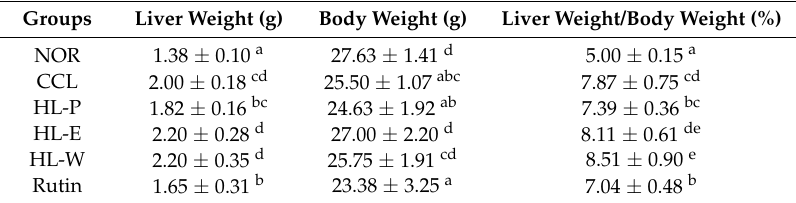
Table 2. The effects of red quinoa and its extracts on body weight, liver weight and liver weight/body weight ratio of the CCl 4 -induced liver injury